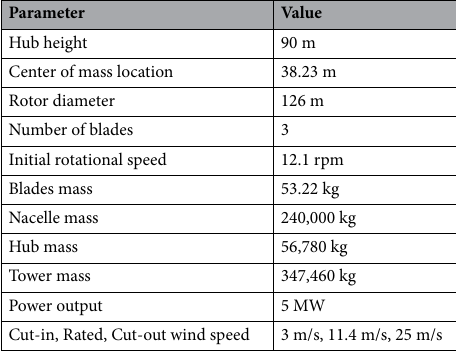
Table 1. 5-MW FOWT